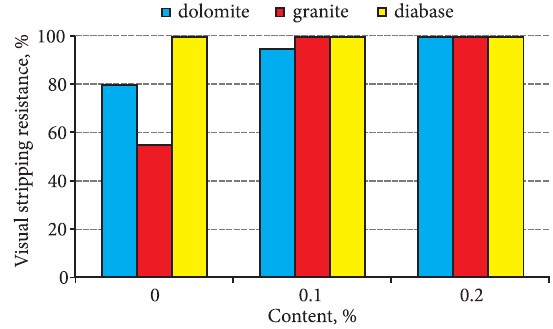
Fig. 4. Stripping resistance with bitumen BDUS 70/100 from Russia containing polyaminoamide based liquid